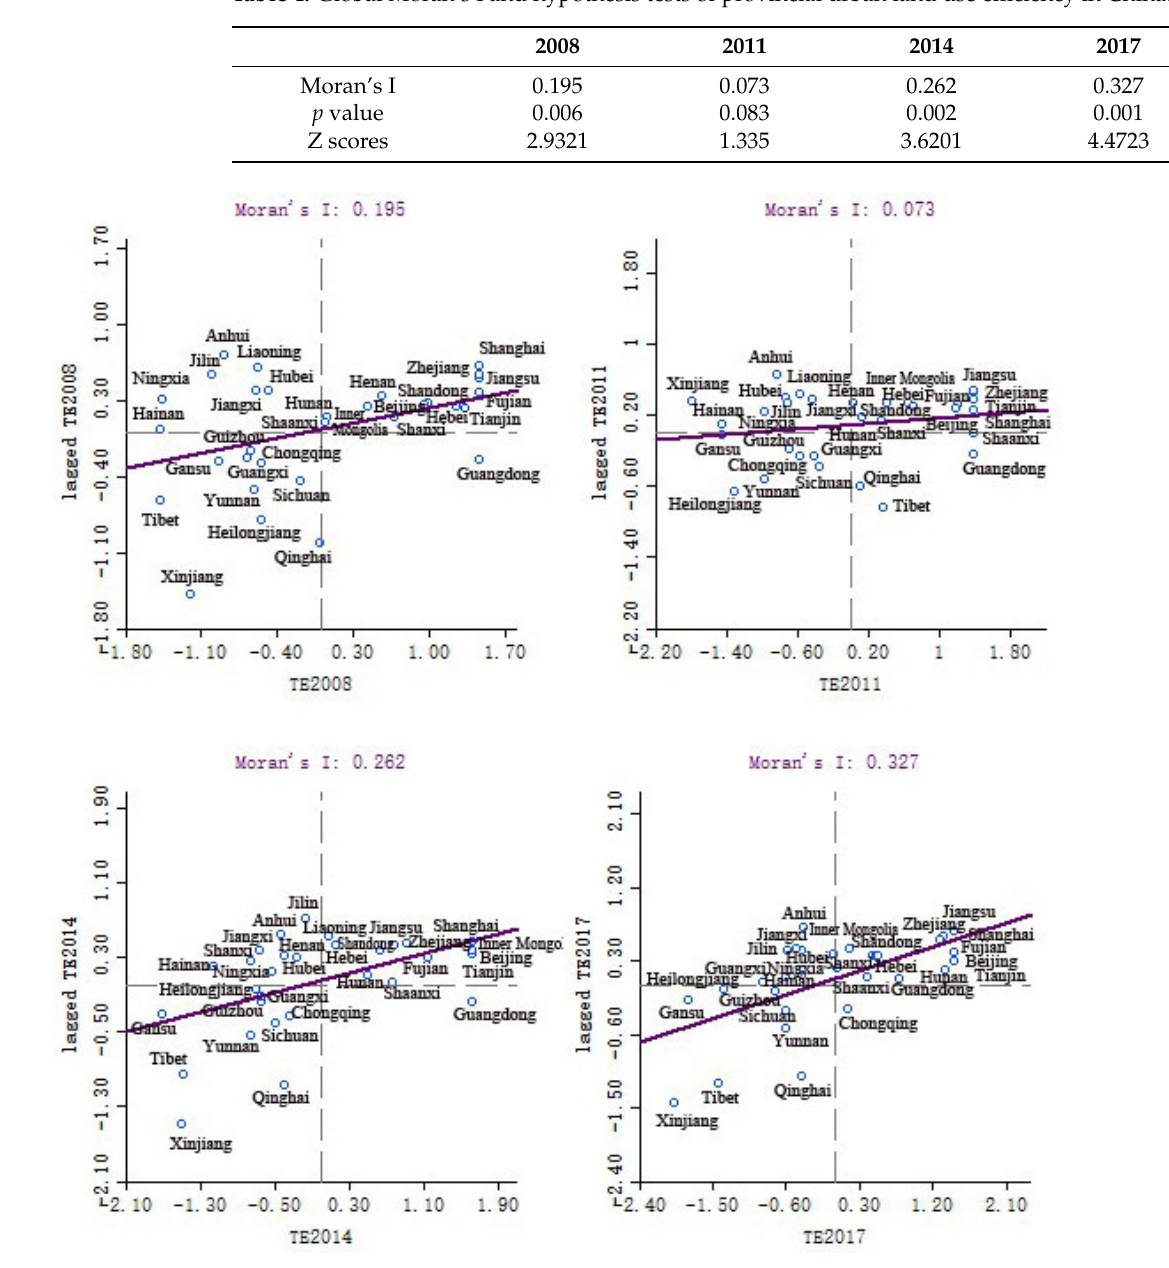
Table 4. Global Moran’s I and hypothesis tests of provincial urban land use efficiency in China.